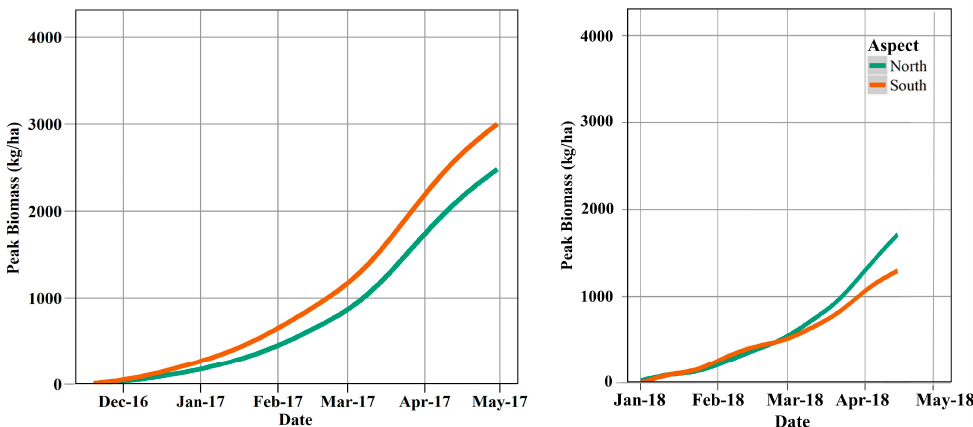
Figure 12. Daily average biomass time series of biomass averaged over 500 randomly selected pure forage pixels (at 30cm resolution) in the study area during 2017-2018 growing season. The time series shows a different phenology for plants growing on south- and north-facing slopes.